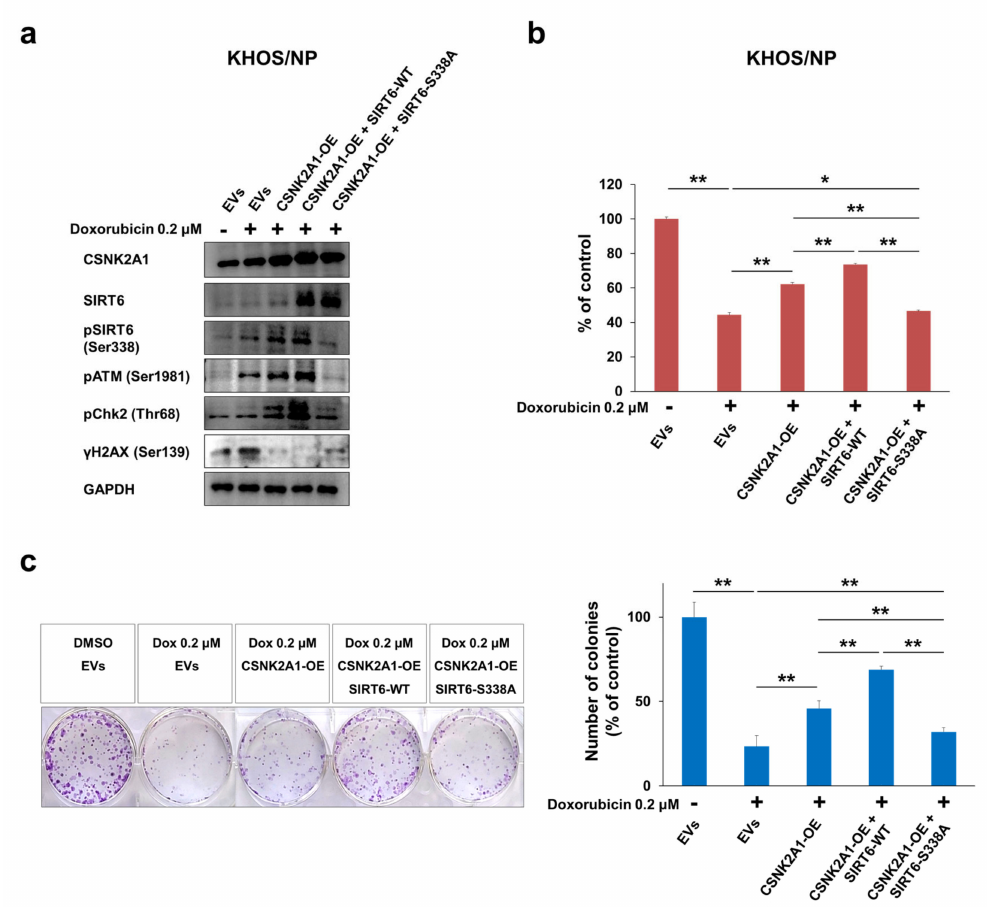
Figure 7. CSNK2A1 involvement in doxorubicin resistance through SIRT6-phosphorylation-mediated activation of the DNA damage repair pathway. ( a ) KHOS/NP cells transfected with empty vectors (EVs), WT-CSNK2A1, WT-CSNK2A1 and WT-SIRT6 (SIRT6-WT; pFLAG2_SIRT6) or WT-CSNK2A1 and mutant SIRT6 (pSIRT6-S338A; pFLAG2_SIRT6_S338A) were treated with 0.2 µ M doxorubicin, and Western blots were performed for CSNK2A1, SIRT6, phosphorylated SIRT6 (pSIRT6, Ser338), phosphorylated ATM (pATM), phosphorylated Chk2 (pChk2), phosphorylated H2AX ( γ H2AX, ser138), and GAPDH. ( b ) The proliferation of transfected KHOS/NP (1 × 10 3 ) cells with indicated vectors was measured 24 h after seeding with a CCK8 proliferation assay. ( c ) Colony-forming assays were performed by seeding transfected KHOS/NP (2 × 10 3 ) cells with the indicated vectors after treatment with DMSO or 0.2 µ M doxorubicin in 6-well culture plates. The cells were grown for ten days. Clono-Counter software was used in the quantification of the number of colonies. EVs; the cells transfected with both empty vector for CSNK2A1 and empty vector for SIRT6. *; p < 0.05, **; p <